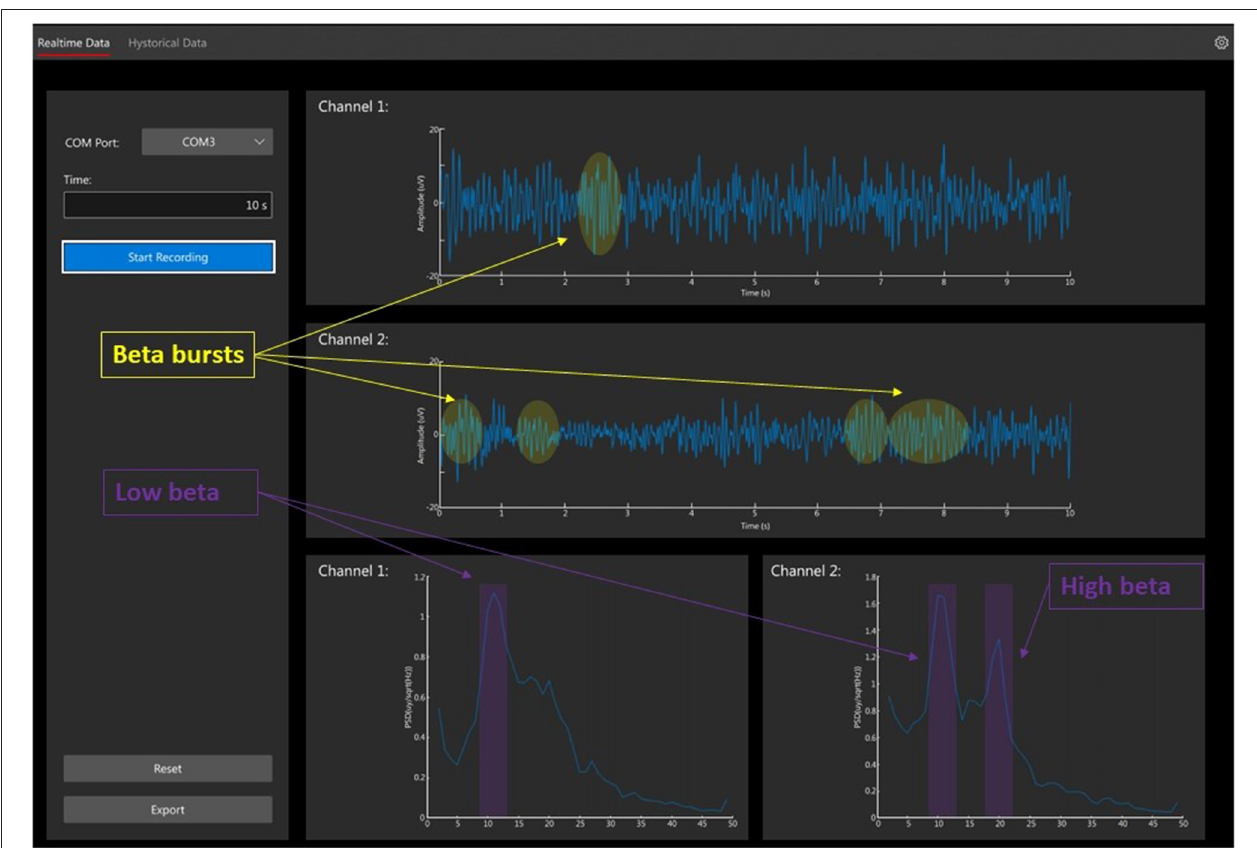
FIGURE 6 | Local field potential recordings (LFPs). The figure shows the recording from n = 2 subthalamic nuclei in a patient with Parkinson disease. The raw LFP signal of a 10-s recording is presented in the 2 top traces. The frequency spectra are displayed in the 2 bottom graphs. LFPs are recorded and filtered with 8th poles low pass filter, corner frequency at 40Hz, for stimulus artifact suppression (AlphaDBSvext, Newronika, Italy). The device streams the signal via radiofrequency to the receiver connected to the computer. Beta bursts activities are highlighted in yellow with low and high beta peeks in